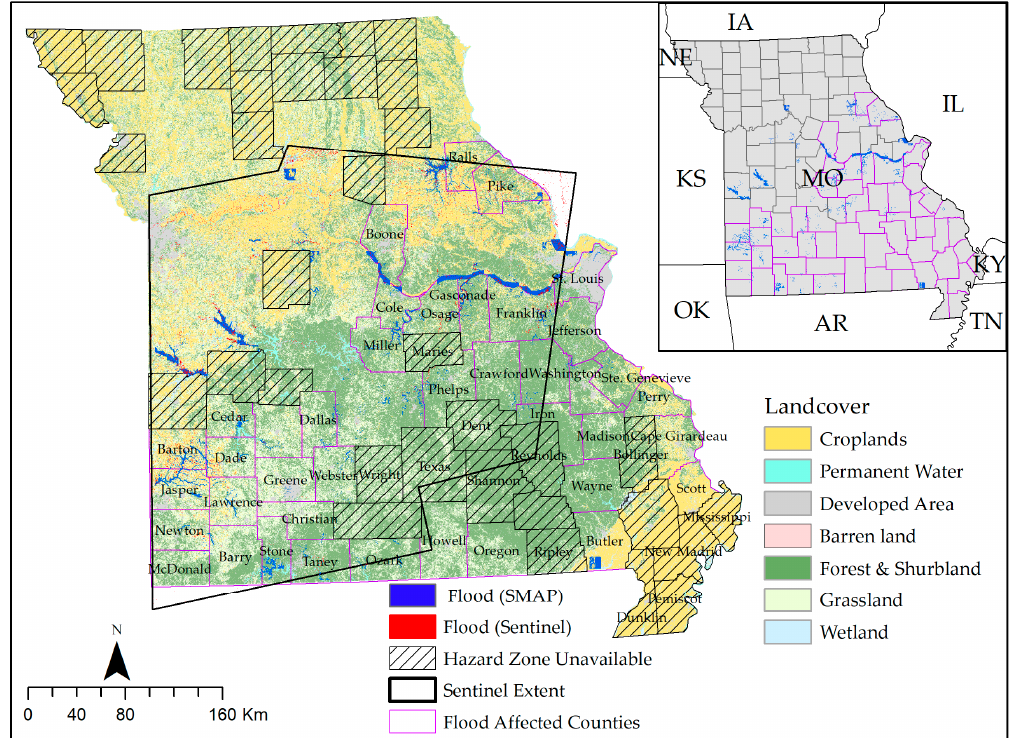
Figure 8. Inundation area extracted from SMAP and Sentinel-1 of the Missouri Flood (May 2017) superimposed over CDL. Table 4. The spatial agreement between SMAP and Sentinel-1 derived inundation acreage of the Missouri Flood (May 2017).